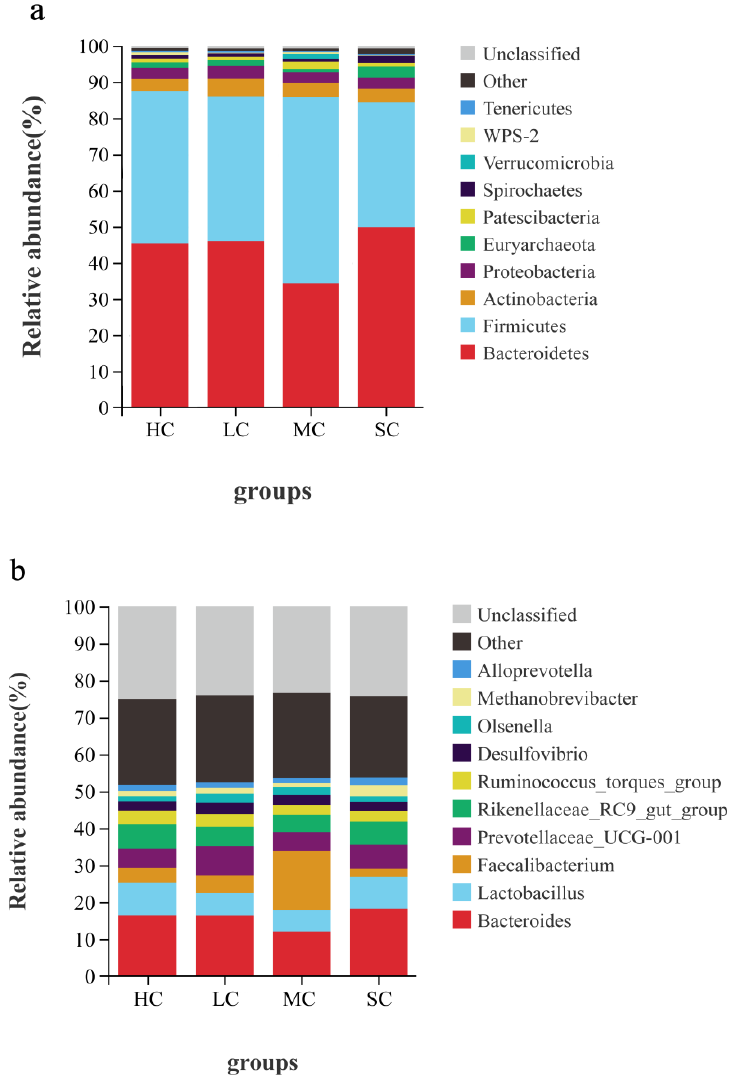
Figure 6. Relative abundance of caecal microbiome at the phylum ( a ) and genus ( b ) levels in laying hens reared in HC, LC, MC, and SC. HC, huge cage; LC, large cage; MC, medium cage; SC, small cage. At the genus level, a total of 301 different genera were detected, and the most abun- dant bacteria were Bacteroides, Lactobacillus, Faecalibacterium,